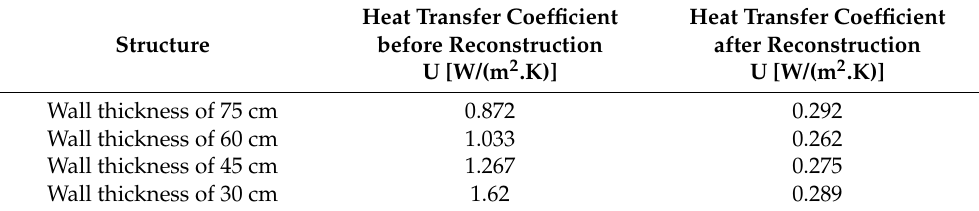
Figure 17. Block of Flats with Parterre. Vít ě zné nám ě stí 577/2, Dejvice, Prague 6, Czech Republic.